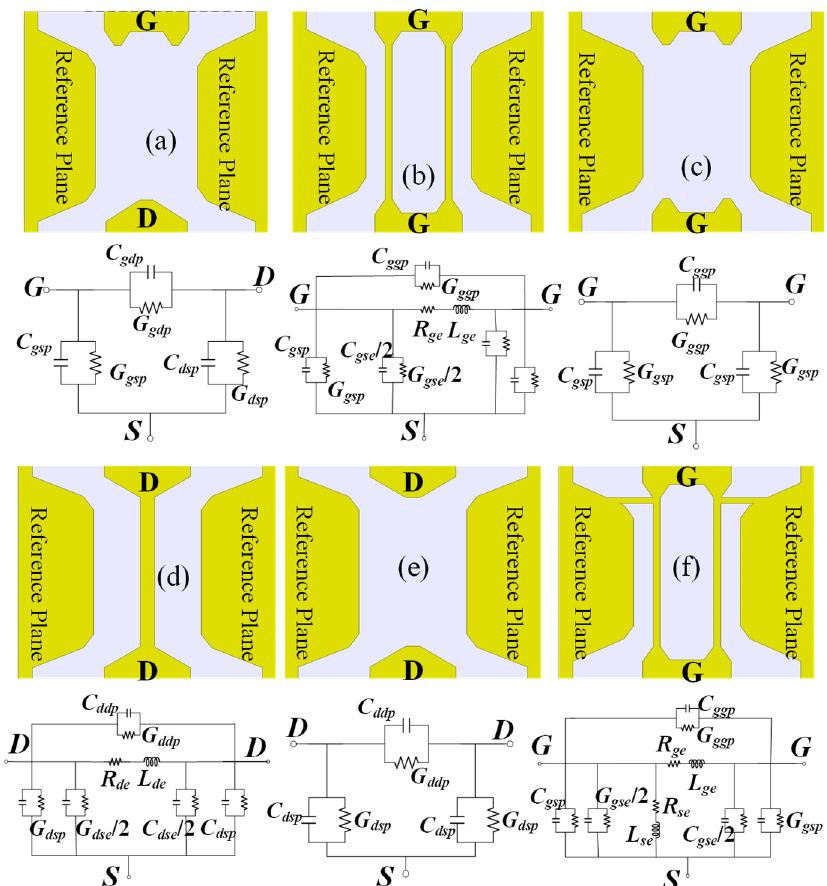
Figure 4. Improved test structure and corresponding sub-circuit model for extrinsic G parasitic circuit extraction. ( a ) PAD; ( b ) THRU1; ( c ) THRU1_PAD; ( d ) THRU2; ( e ) THRU2_PAD; and ( f )